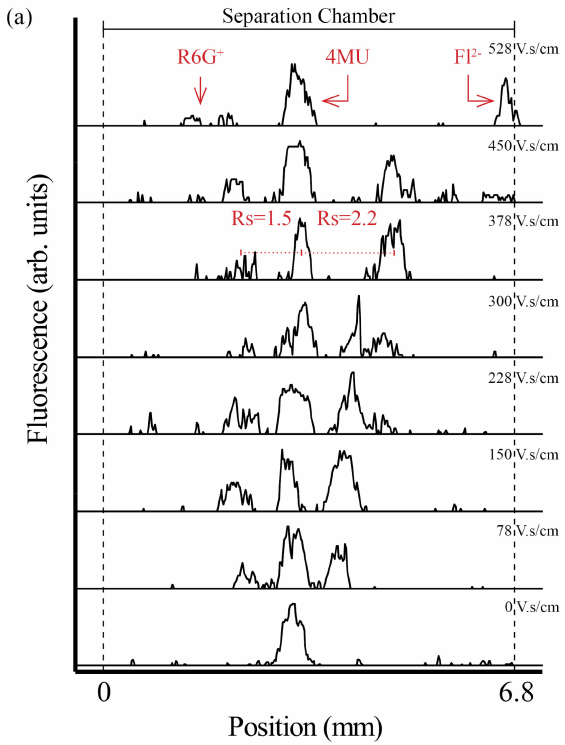
Figure 4. ( a – d ) Fluorescence images of the sample mixture separation, using the µ FFE device, at increasing separation power and a constant flow velocity of 4.1 mm/s. RGB channel intensities were optimized and converted to grayscale images for